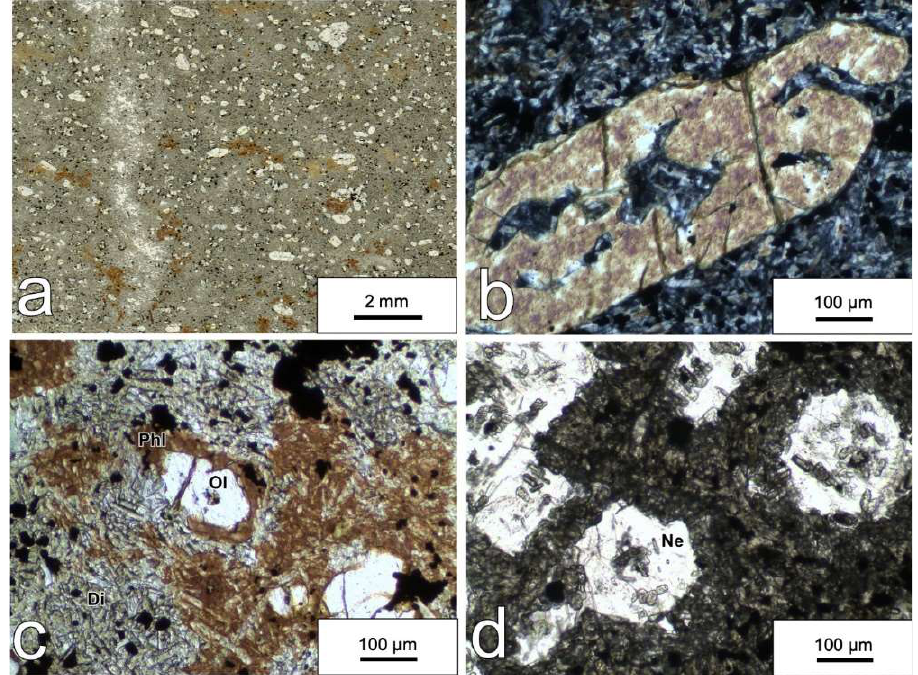
Figure 2. ( a ) Thin-section scan in polarized light showing the porphyritic texture of the monchiquite with olivine phenocrysts, phlogopite oikocrysts and a matrix mainly made up of diopside microlites. A vertical band enriched in nepheline can be observed on the left of the scan; ( b ) micrograph showing an olivine phenocryst with skeletal texture within the diopside-rich matrix (crossed polars); ( c ) micrograph showing oikocrysts of phlogopite enclosing numerous chadacrysts and a resorbed olivine surrounded by a thin corona of phlogopite (plane polarized light); ( d ) micrograph showing basal and longitudinal sections of nepheline microphenocrysts (plane polarized light). Phl—phlogopite; Ol—olivine; Di—diopside; Ne—nepheline.